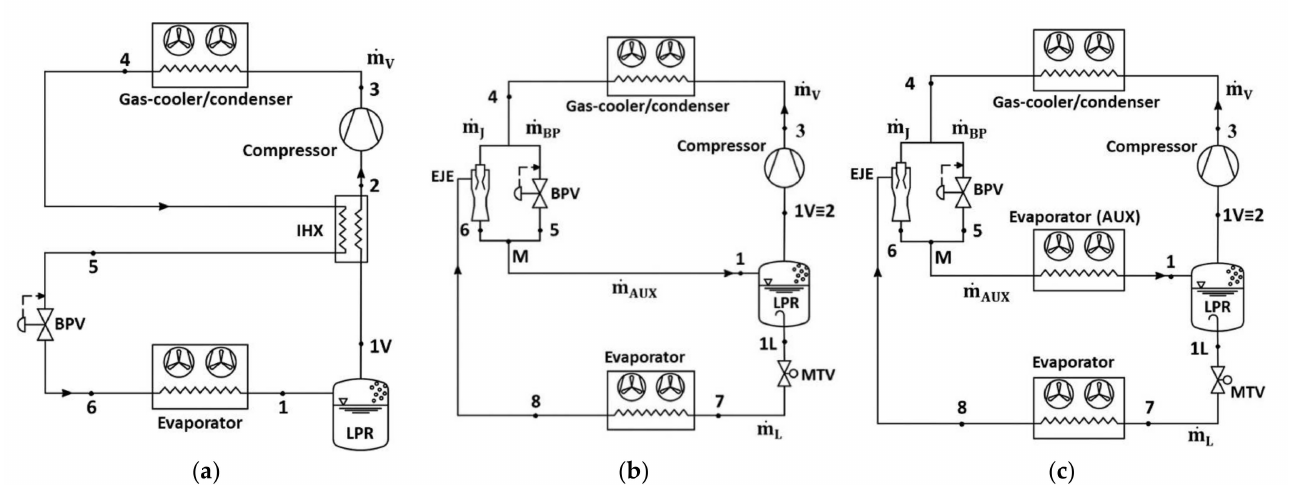
Figure 23. Schematic of the cooling unit working with: ( a ) low pressure receiver configuration; ( b ) ejector cycle configuration using a single evaporator; ( c ) ejector cycle configuration using an auxiliary evaporator. Reprinted from ref. [72], Copyright (2020), with permission from